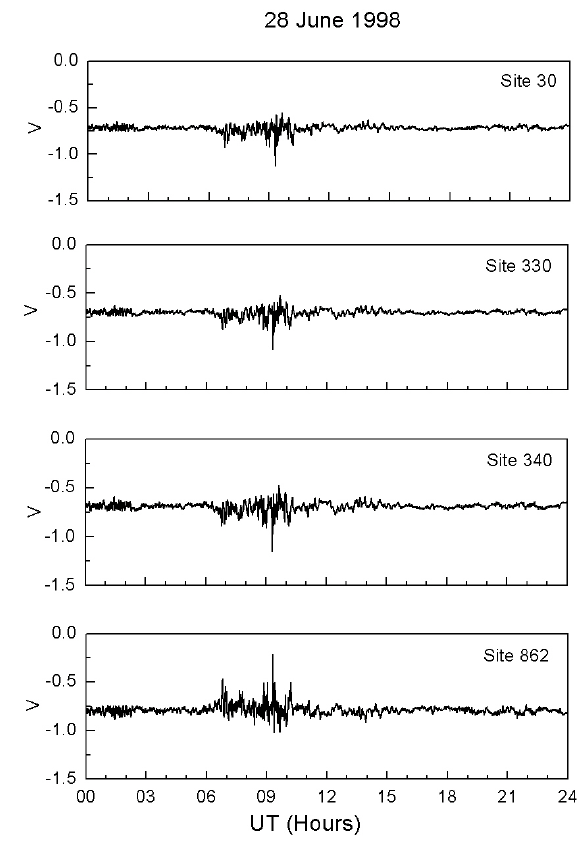
Fig. 11. Modelled pipe-to-soil potential for different sites on the Norman Wells – Zama pipeline for low terminating